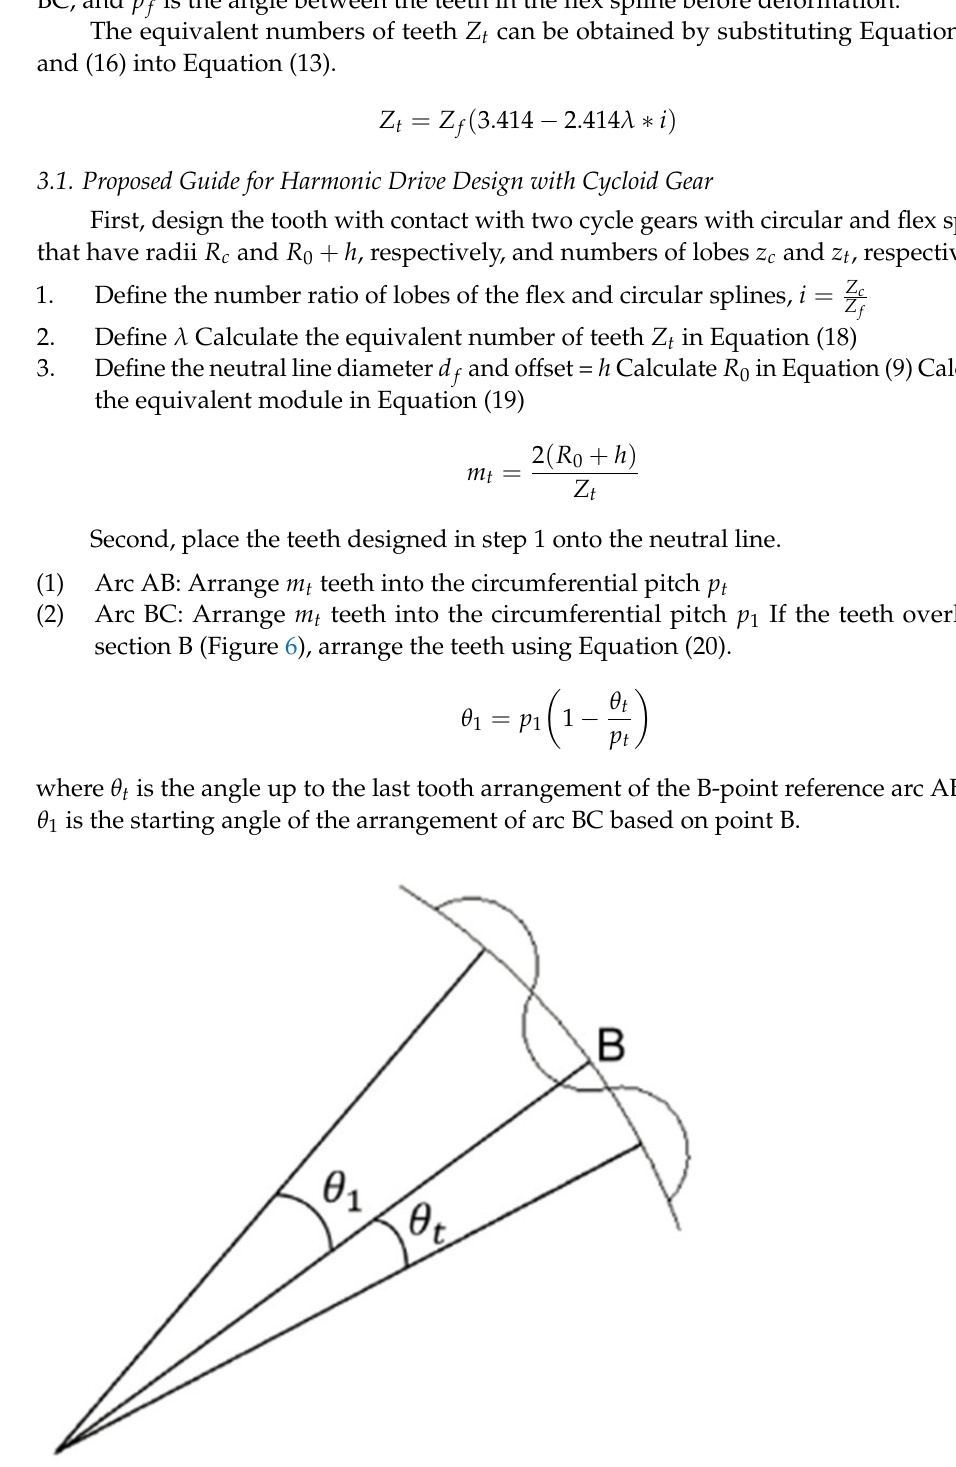
and module 𝑚 . (cid:3030) (cid:3047)